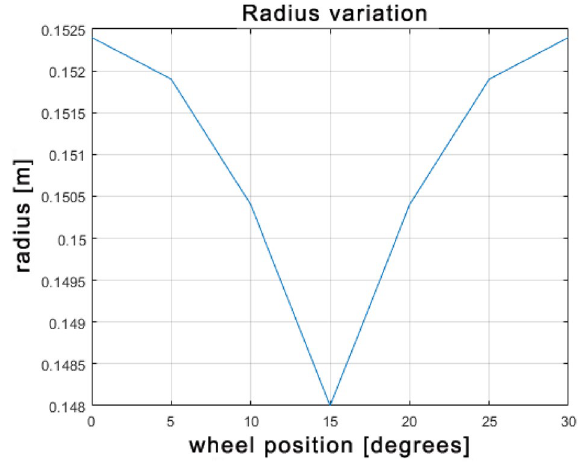
Figure 6. Radius variation against the wheel angular